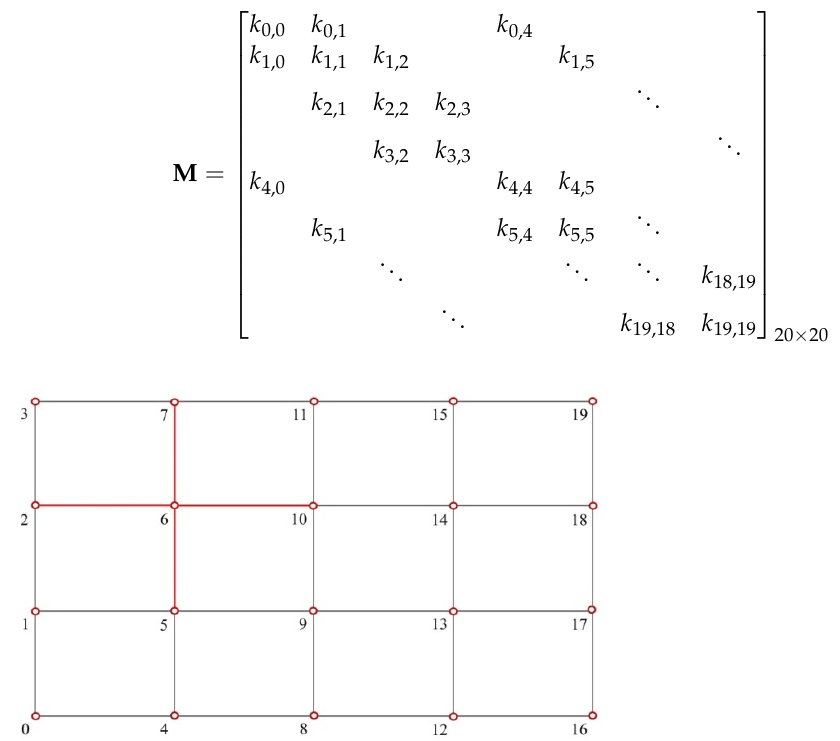
Figure 1. Mesh generation of the model of spontaneous combustion of coal in goaf area.